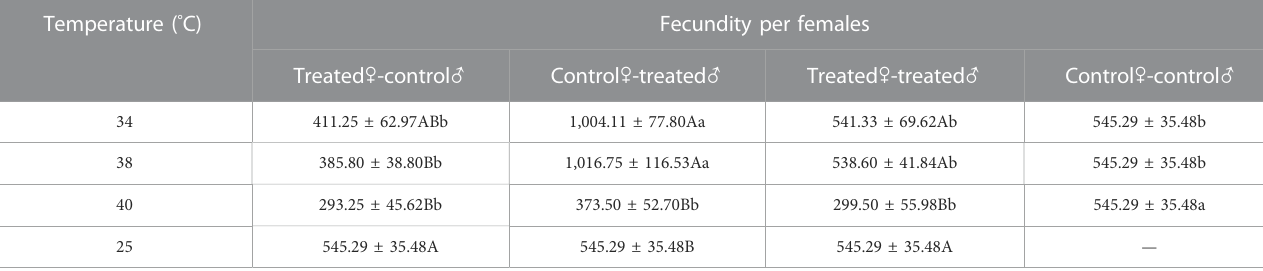
TABLE 5 Fecundity of Z. tau adults exposed to different high-temperature treatments for 12 h. Temperature ( °